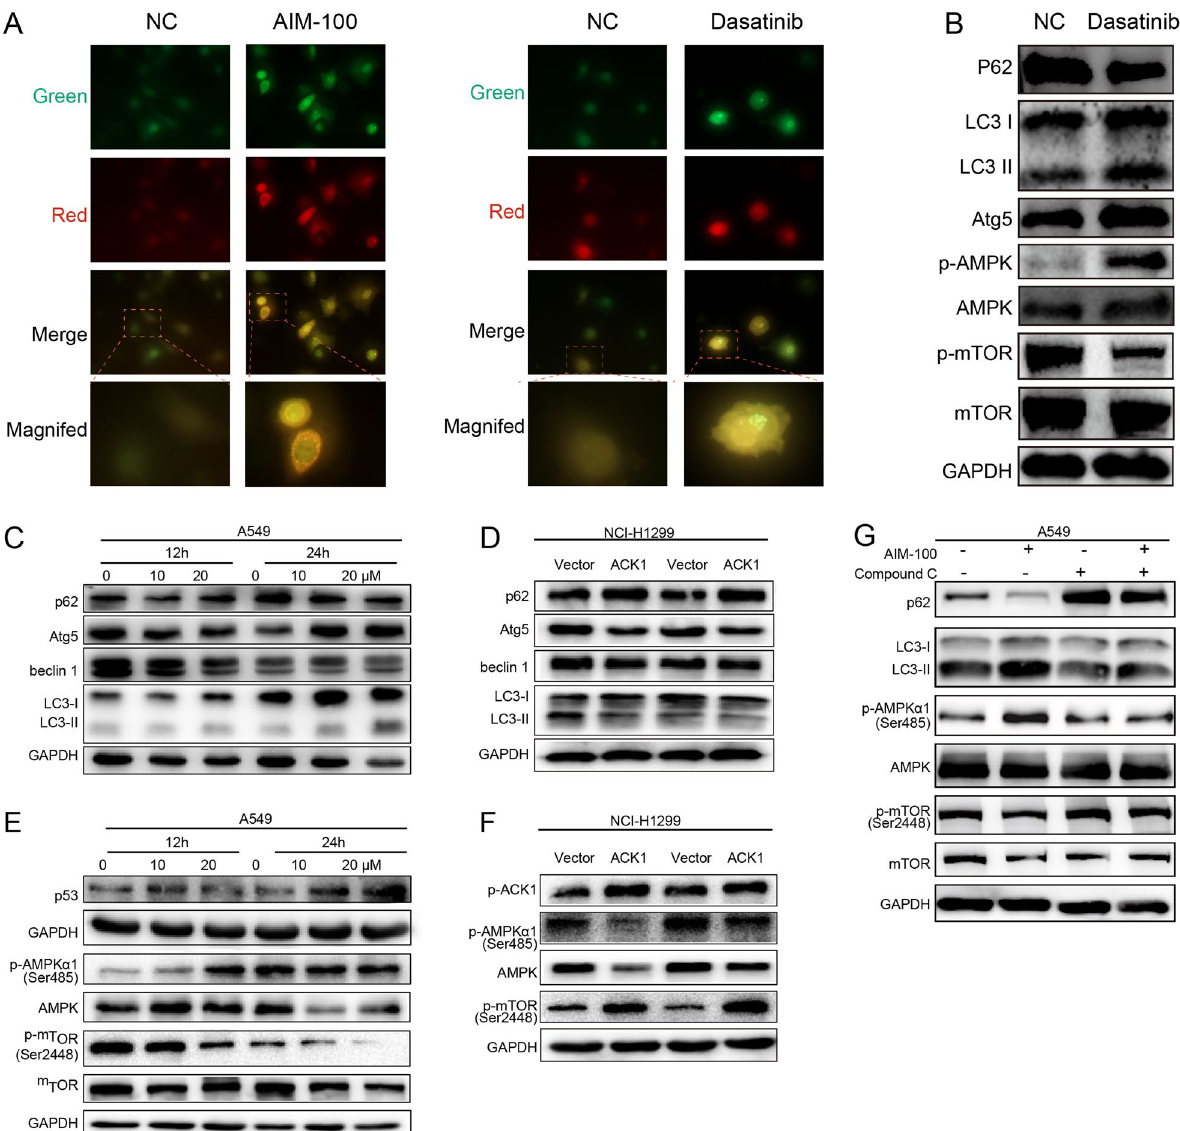
Fig. 6 Suppressing ACK1 stimulated an autophagy-like response and activated the AMPK/mTOR pathway in lung cancer cells. A A549 cells were infected with adenoviral vectors carrying mRFP-GFP-LC3 and cultured for 24 h, followed by incubation with AIM-100 (20 μM) or Dasatinib (20 μM) for an additional 12 h. mRFP-LC3 and GFP-LC3 puncta, representing autophagosomes, in A549 cells induced by AIM-100 or Dasatinib (at magnification). The number of LC3 puncta per cell was quantitated. B A549 cells were treated with Dasatinib (20 μM) for 12 h. Cell lysates were analyzed, and immunoblots were probed with indicated antibodies. C , E ) A549 cells were treated with different concentrations of AIM-100 for indicated hours. Influences of AIM-100 on common biomarkers of autophagy C and the AMPK/mTOR signaling pathway E were examined. D , F NCI-H1299 cells were used to investigate the effects of ACK1 overexpression on the biomarkers of autophagy ( D ) and the AMPK/mTOR signaling ( F ). G A549 cells were incubated with AIM-100 (20 μM) and/or AMPK inhibitor (Compound C, 20 μM) for 12 h, succeeded by Western blot. *P < 0.05, **P < 0.01, ***P <